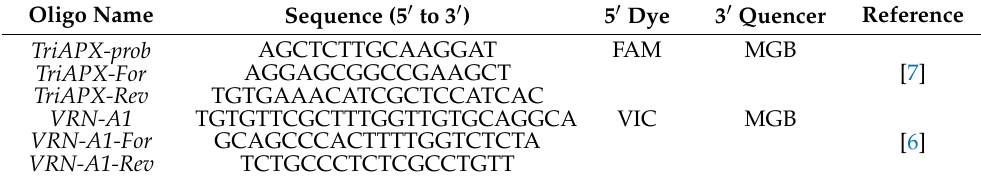
Table 9. Primers and probes sequences and references are reported. The VRN-A1 assay was used to check VRN-A1 copy number variation. The TriAPX assay targets a single copy Triticum aestivum sequence Pinb-D1 .